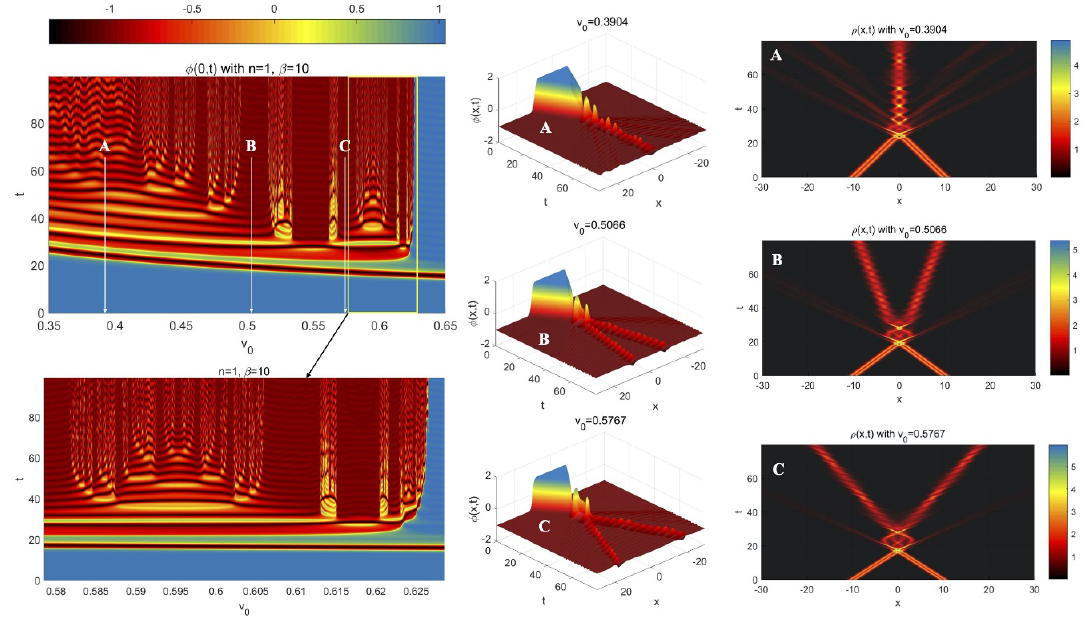
Figure 8 . For n = 1 ; (cid:12) = 10, v 0 2 [0 : 35 : 0 : 00005 : 0 : 65] we (cid:12)nd two wider two-bion escape windows in the vicinity of v 0 = 0 : 5 and v 0 = 0 : 55, respectively. We also plot the scalar con(cid:12)gurations